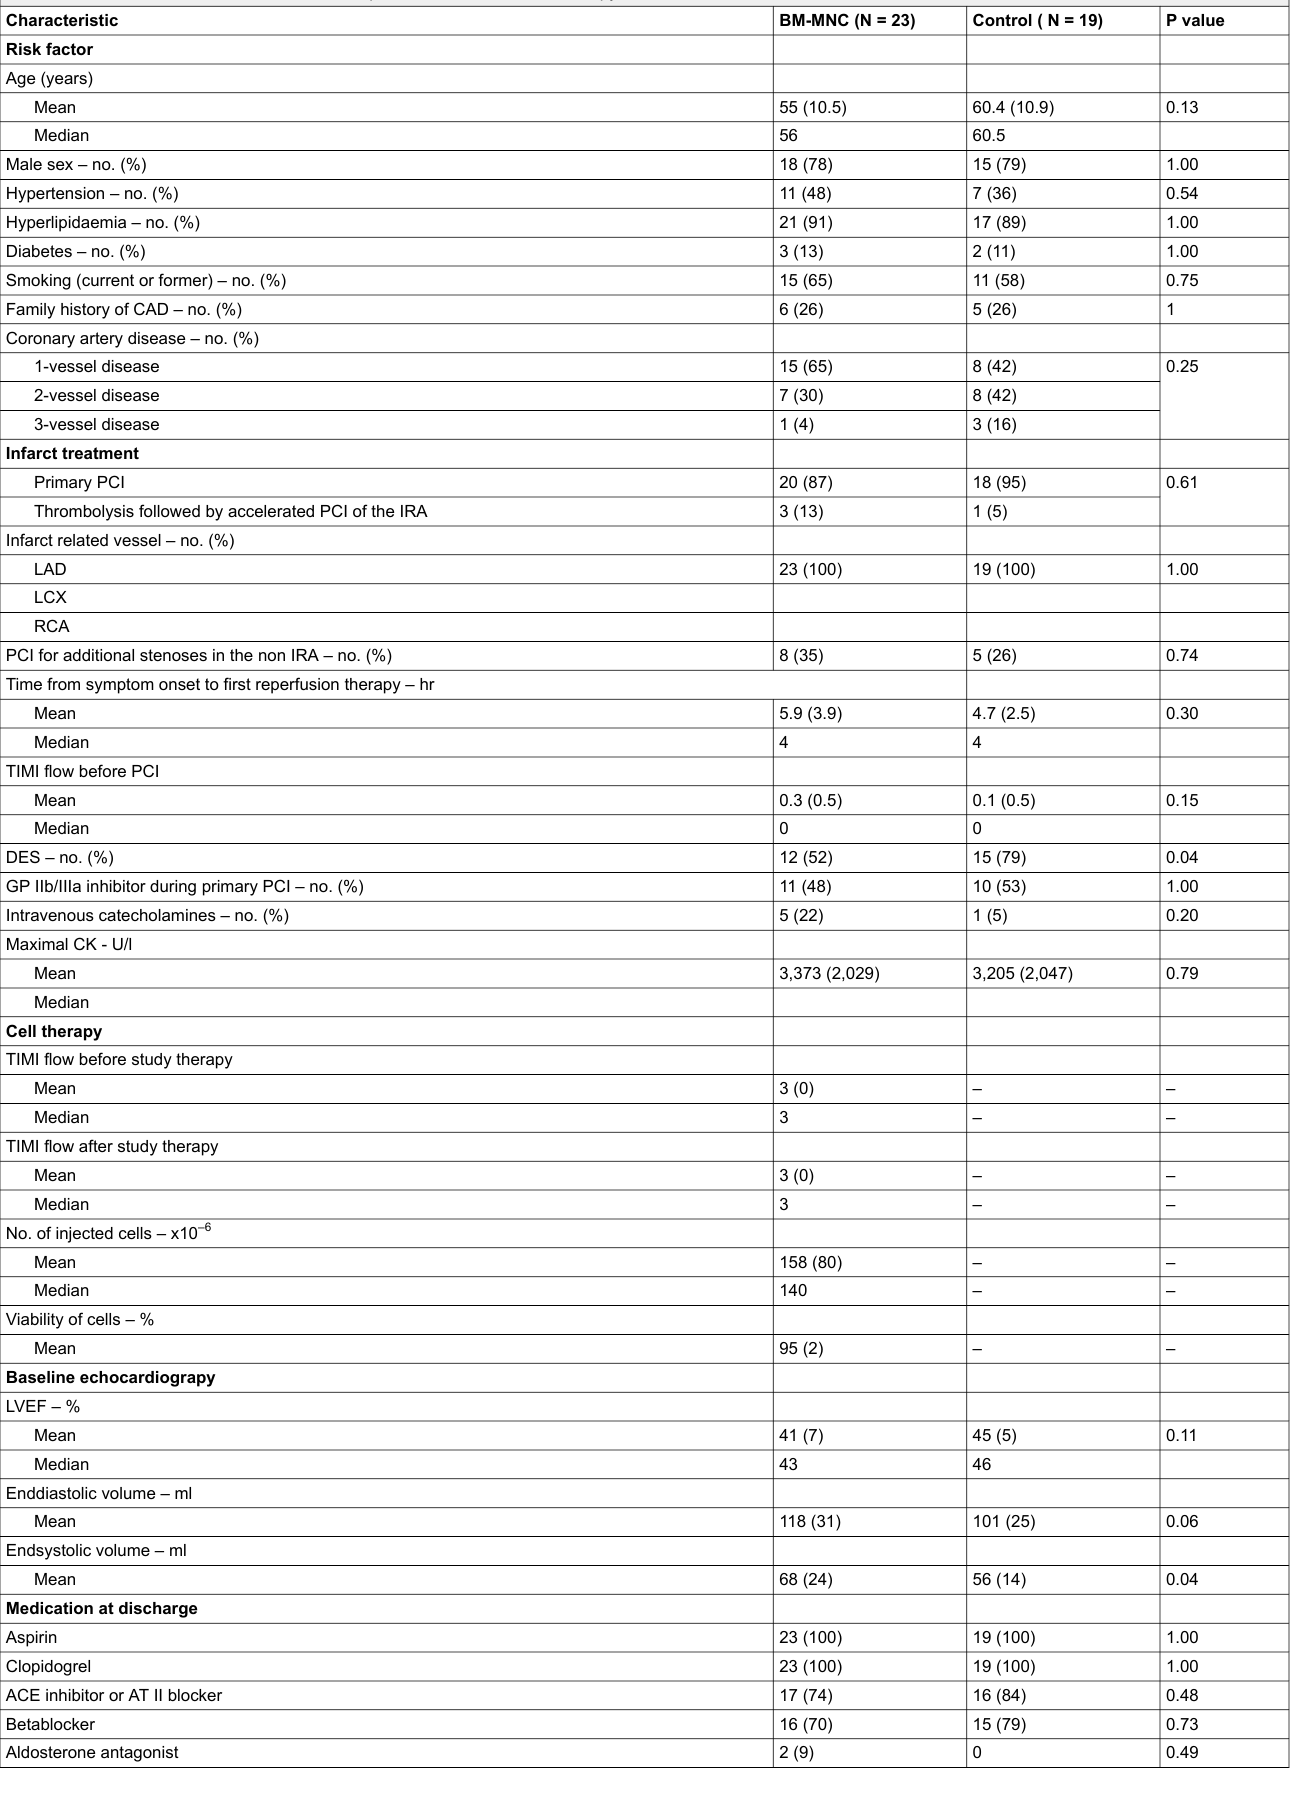
Table 3: Baseline characteristics of the included patients and concomitant